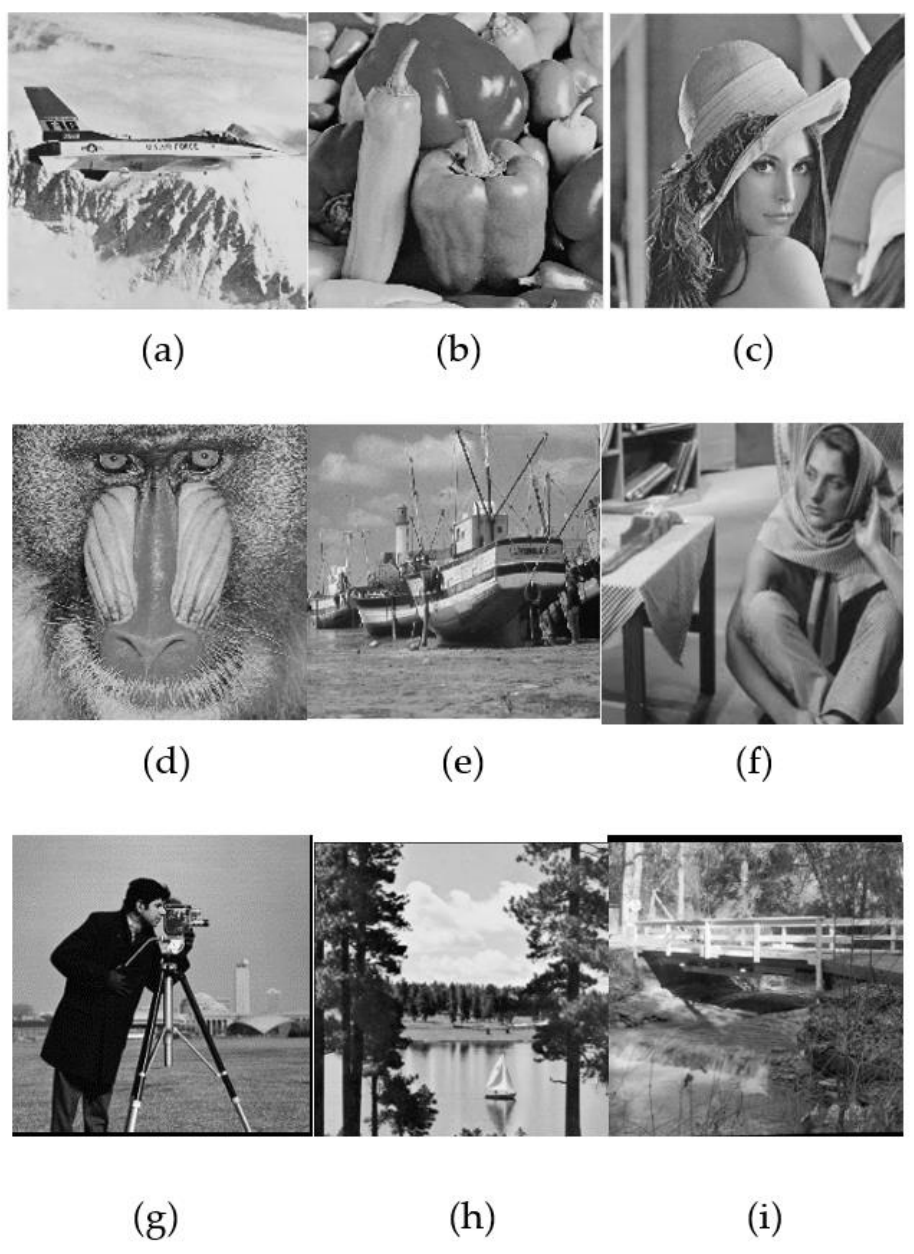
Figure 5. Used host images in this paper: ( a ) Lena; ( b ) Peppers; ( c ) Airplane; ( d ) Baboon; ( e ) Ship; ( f ) Barbara; ( g ) Cameraman; ( h ) Lake; ( i ) Bridge.